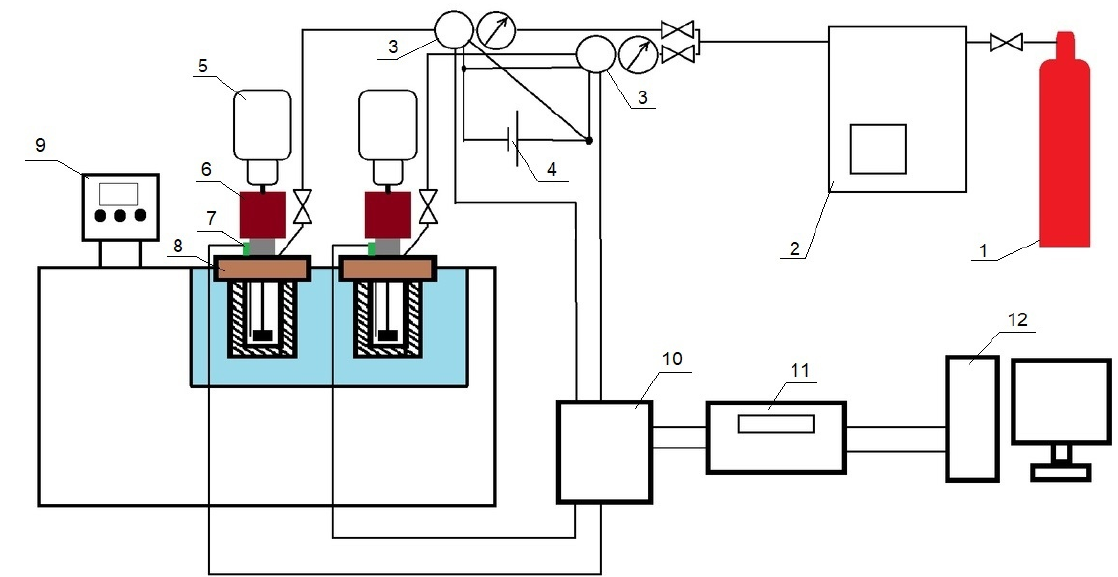
Figure 2. Scheme of the experimental setup for studying hydrate formation under dynamic condi ‐